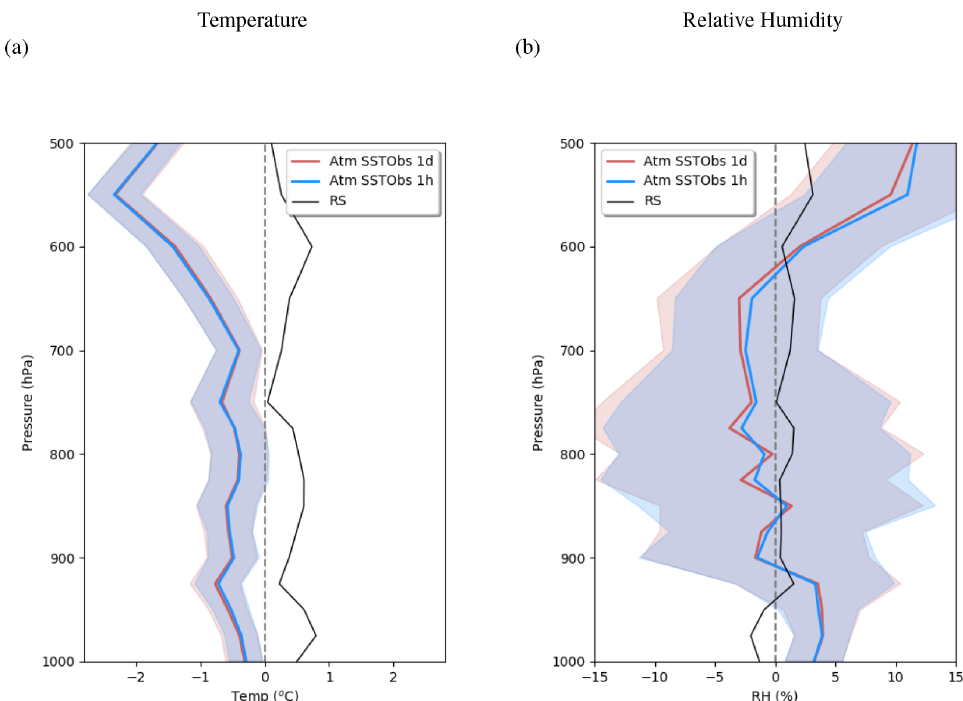
Figure 5. Mean difference in the vertical profile of (a) temperature ( ◦ C) and (b) relative humidity (%) between atmospheric experiments and the Era-Interim reanalysis (Dee et al., 2011) averaged over the simulated period (13–22 November). The shading represents 2 standard deviations of the inter-member ensemble. The black line indicates the difference between the local sounding data from R/V Revelle and the ERA-Interim reanalysis over the same